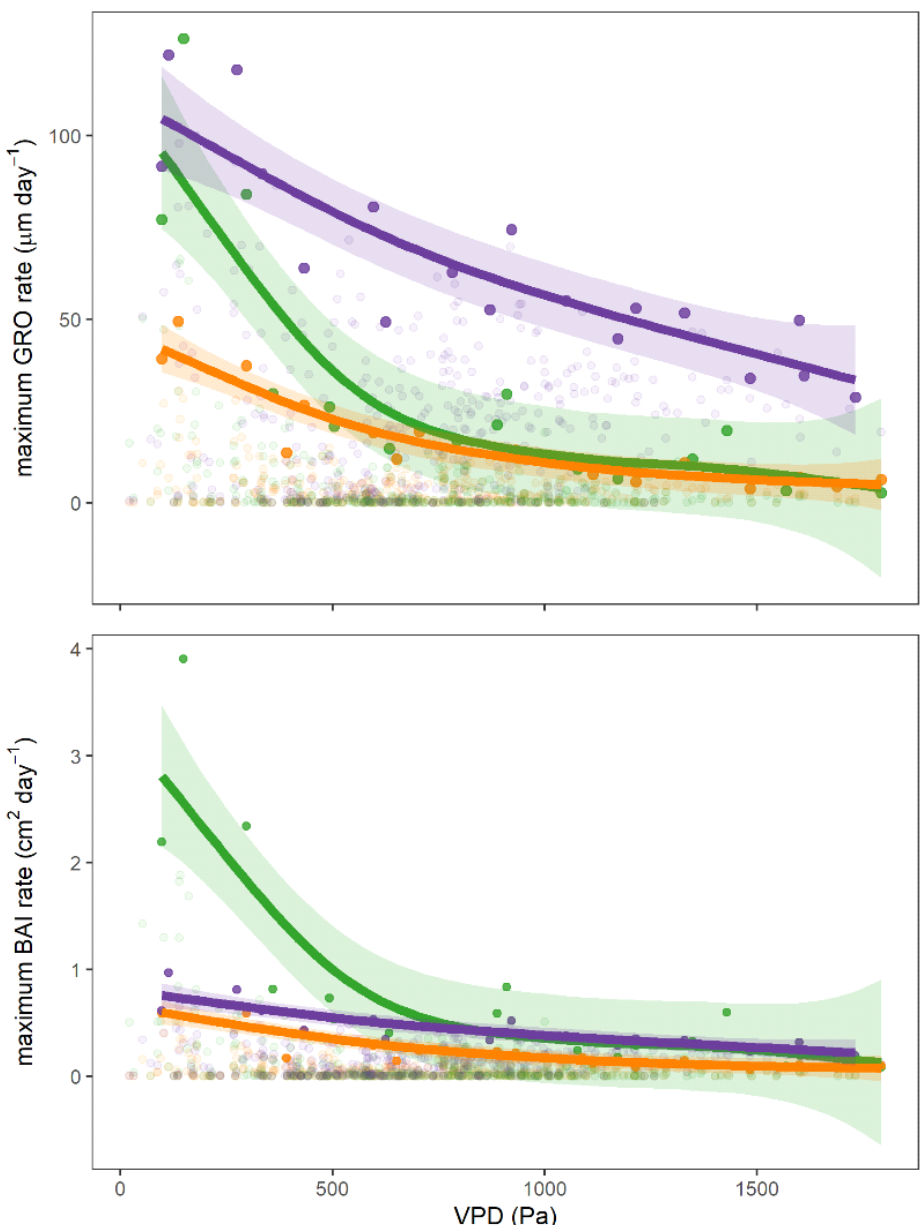
Figure 6. The relationship of mean daily VPD to maximum daily stem radius growth rate (GRO; upper panel) and maximum daily basal area increment rate (BAI; lower panel; larger solid points) smoothed by general additive models (GAM; thick solid lines). Colored area depicts confidence intervals of GAM models; smaller lighter points depict the relationship between GRO and BAI to VPD not fitted by GAM models (see Methods for more information). All GAM models were significant ( p < 0.001) with R 2 > 0.73 using the formula y ~ s(x, bs = “cs”) with the “REML” method.